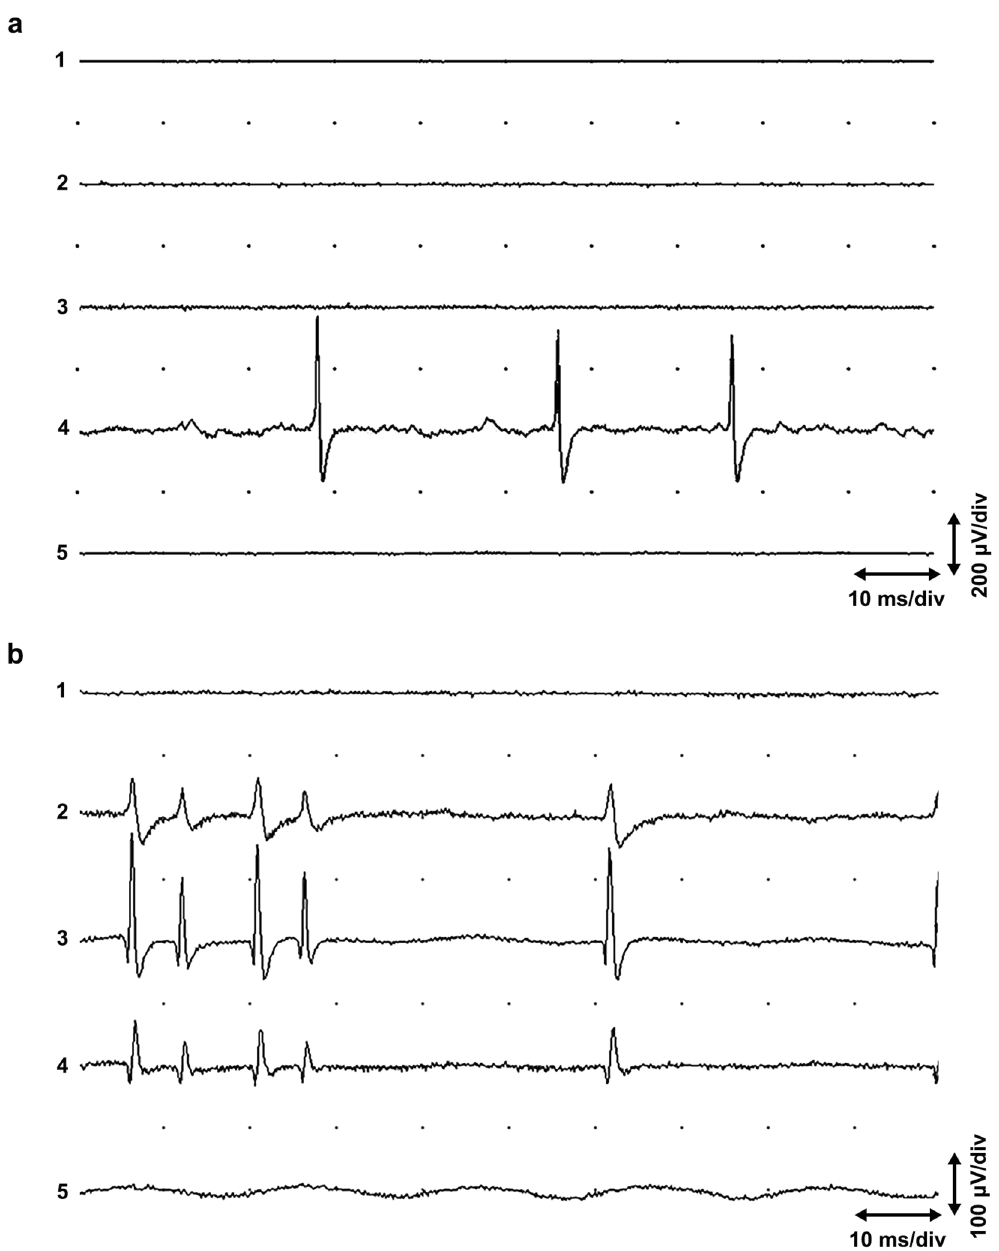
Figure 1. ( a ) Local end plate spikes. Five-channel needle EMG of the extensor carpi radialis muscle showing non-propagating “end plate spikes” with end plate noise in channel 4. The five parallel EMG electrodes (channels 1 − 5) were placed about 2 mm apart in a single fasciculus of the muscle. ( b ) End plate spikes propagating for a short distance (from 39 , with permission). The electrodes as in ( a